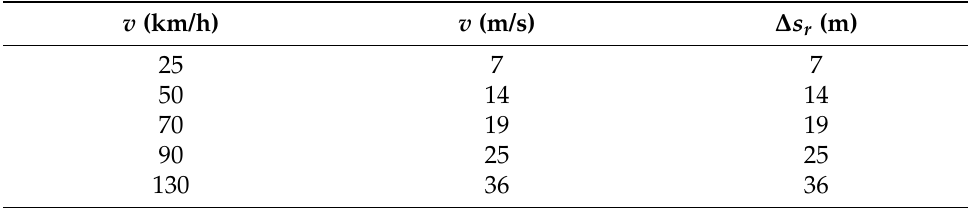
Table 3. Speed and space of